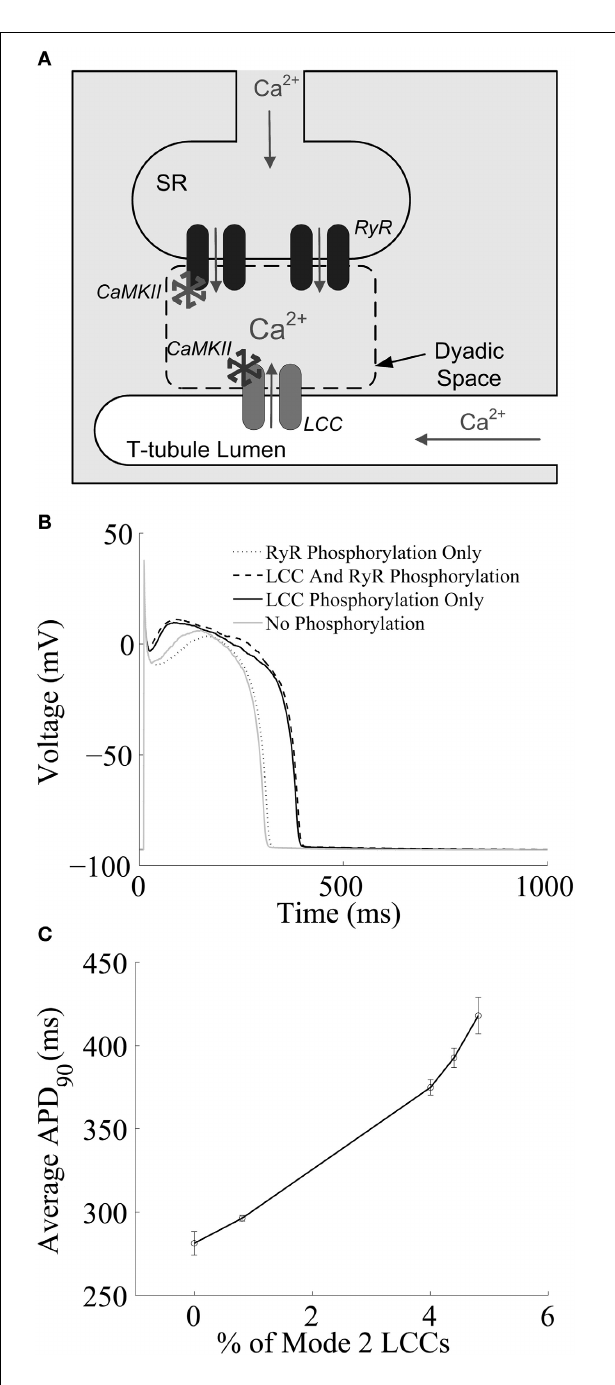
FIGURE 1 | (A) Schematic representation of the cardiac dyad. Ca 2 + ions pass through the LCC and enter the dyad, where they bind to RyRs, triggering CICR. The activity of each CaMKII monomer is a function of dyadic Ca 2 + levels. Ca 2 + ions released from the SR diffuse out of the dyad into the bulk myoplasm. (B) Simulated results from a 1-Hz AP-pacing protocol under different LCC and/or RyR phosphorylation conditions. (C) APD 90 as a function of average LCC phosphorylation levels. Fully phosphorylated LCCs gate in mode 2, which exibit long-duration